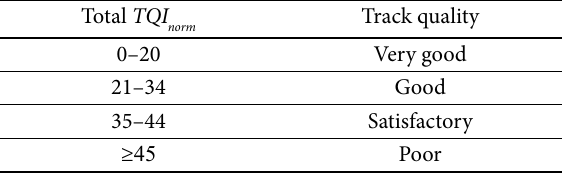
Table 2. Qualitative evaluation of track based on TQI